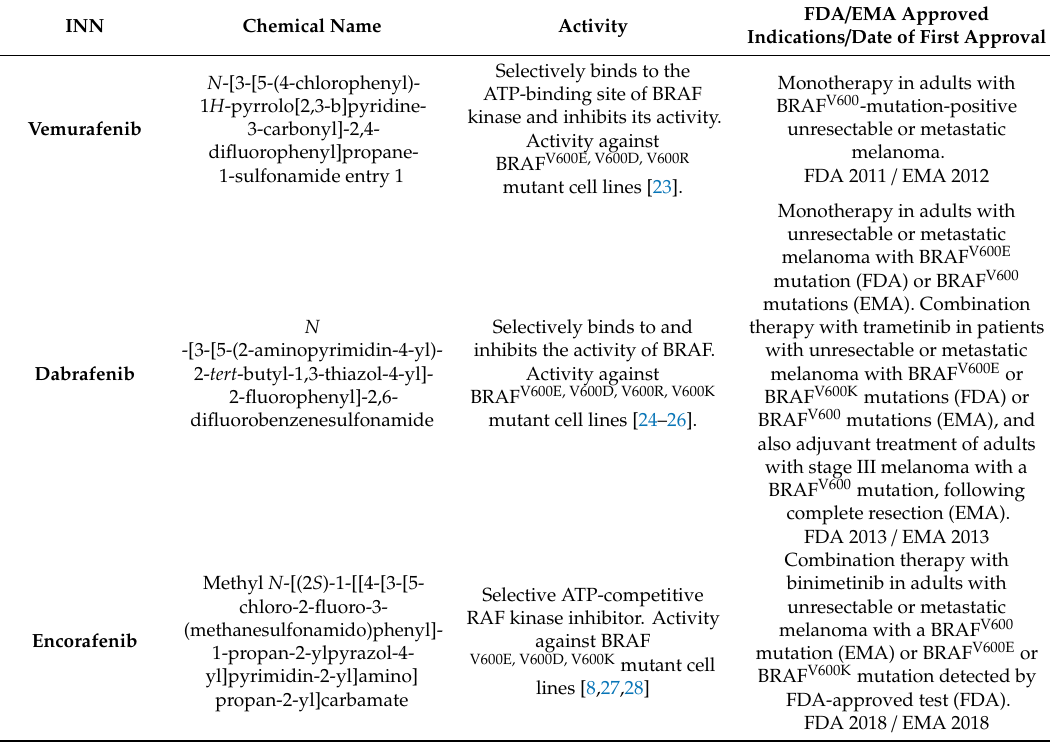
Table 1. BRAF Inhibitors